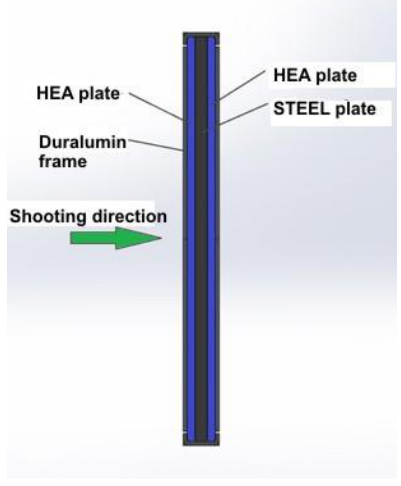
Figure 9. The shooting scheme for structure 3. Metals 2017 , 7 , 496